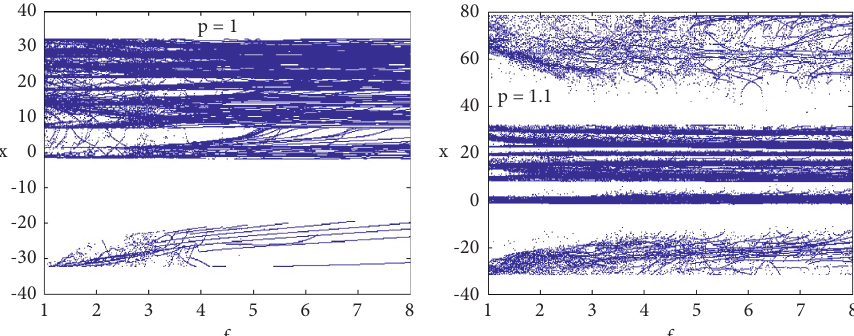
Figure 9: Effect of p on the bifurcation diagrams of the new nonlinear parametric chemical system (1) with the parameters of Figure 8.